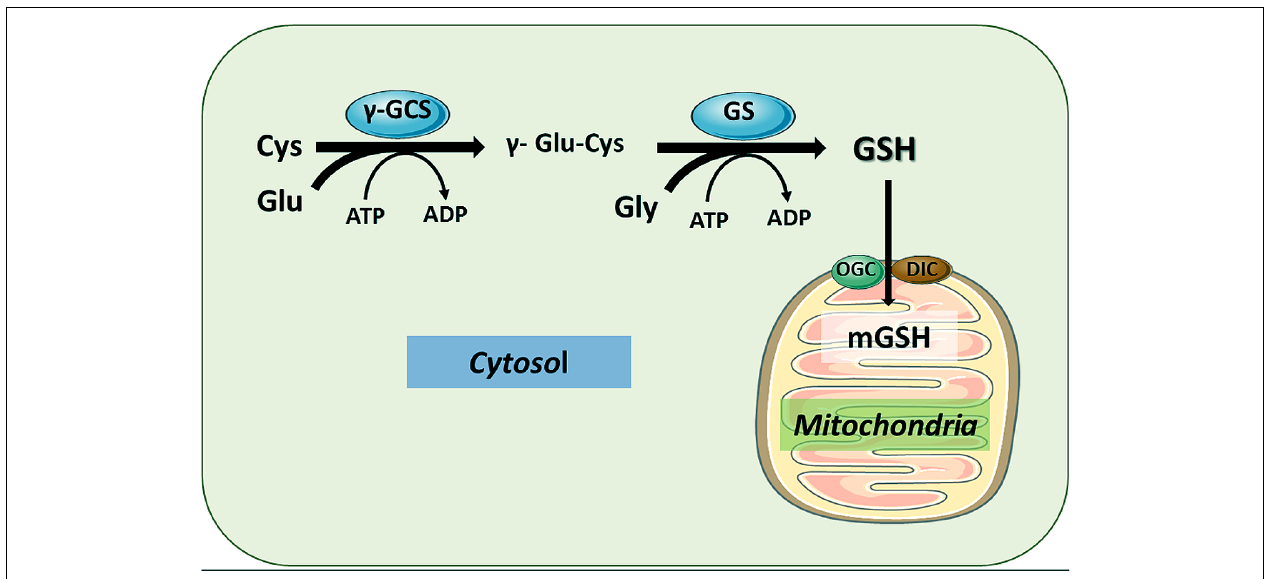
synthesized in the cytosol, GSH can be transported to mitochondrial matrix by different carriers, particularly the 2-oxoglutarate carrier (OGC) and the dicarboxylate carrier (DIC), located in the mitochondrial inner membrane.The function the OGC has been shown to be dependent on changes in mitochondrial membrane